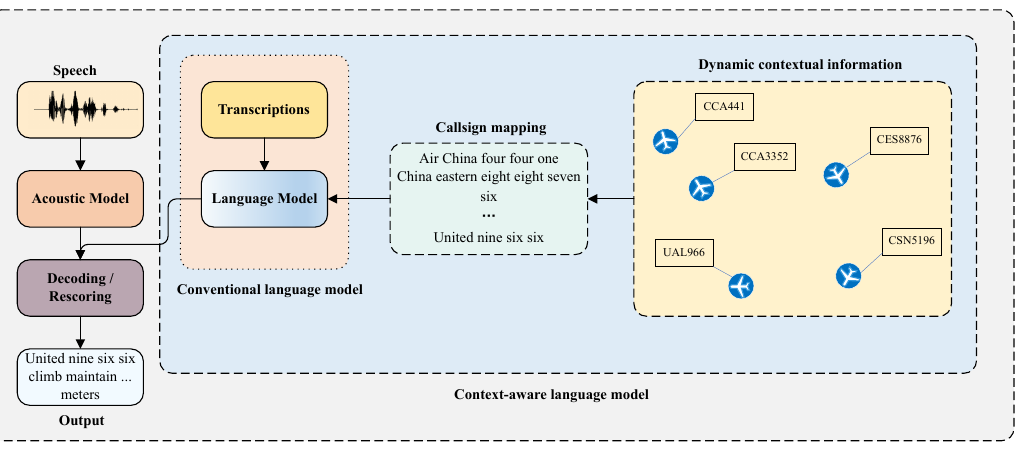
Figure 1. The architecture of contextual ASR system using